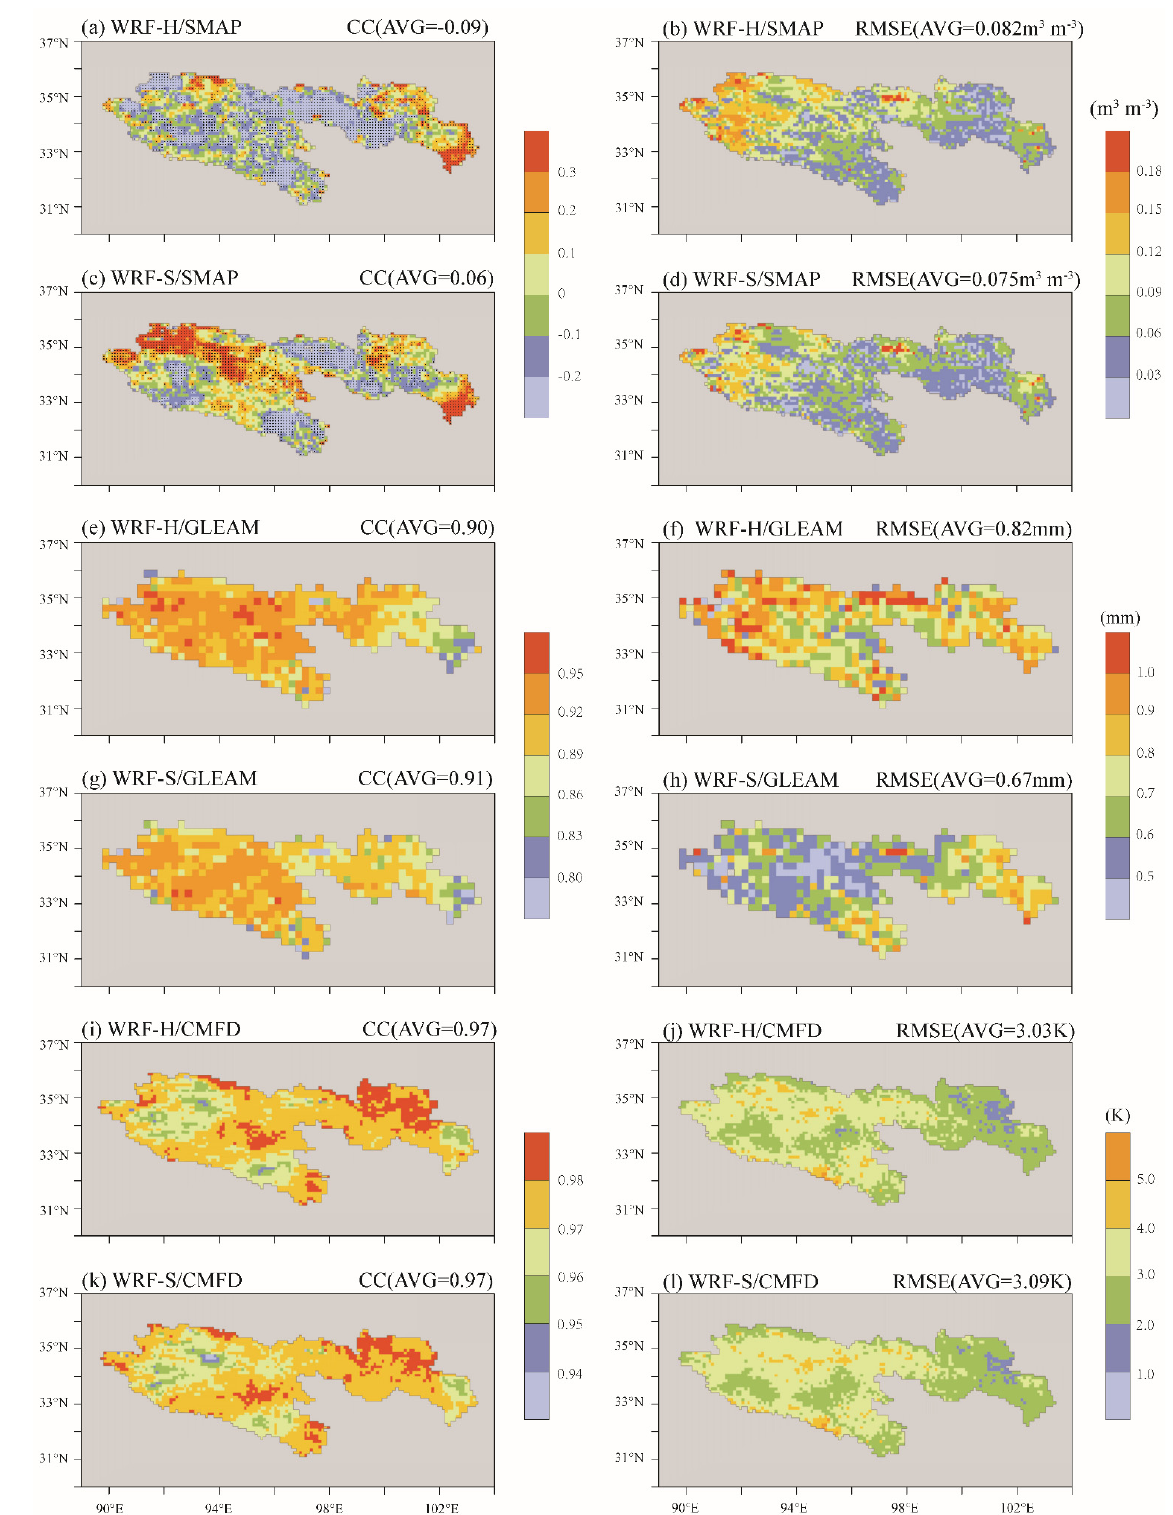
Figure 5. Evaluation of soil moisture, evapotranspiration, and air temperature at 2 m over the SRTR. ( a ) Spatial distribution of correlation coefficient (CC) between satellite retrievals or reanalysis data and soil moisture simulations from WRF-H during the study period; ( b ) Same as ( a ), but for spatial distribution of RMSE; ( c , d ) Same as ( a , b ), but simulations are from WRF-S; ( e – h ) Same as ( a – d ), but for evapotranspiration; ( i – l ) Same as ( a – d ), but for air temperature at 2 m. The dots in ( a ) and ( c ) denote the correlation coefficient and are significantly above the 95% confidence level, and the correlation coefficient in each grid point of ( e , g , i , k ) passed the significance